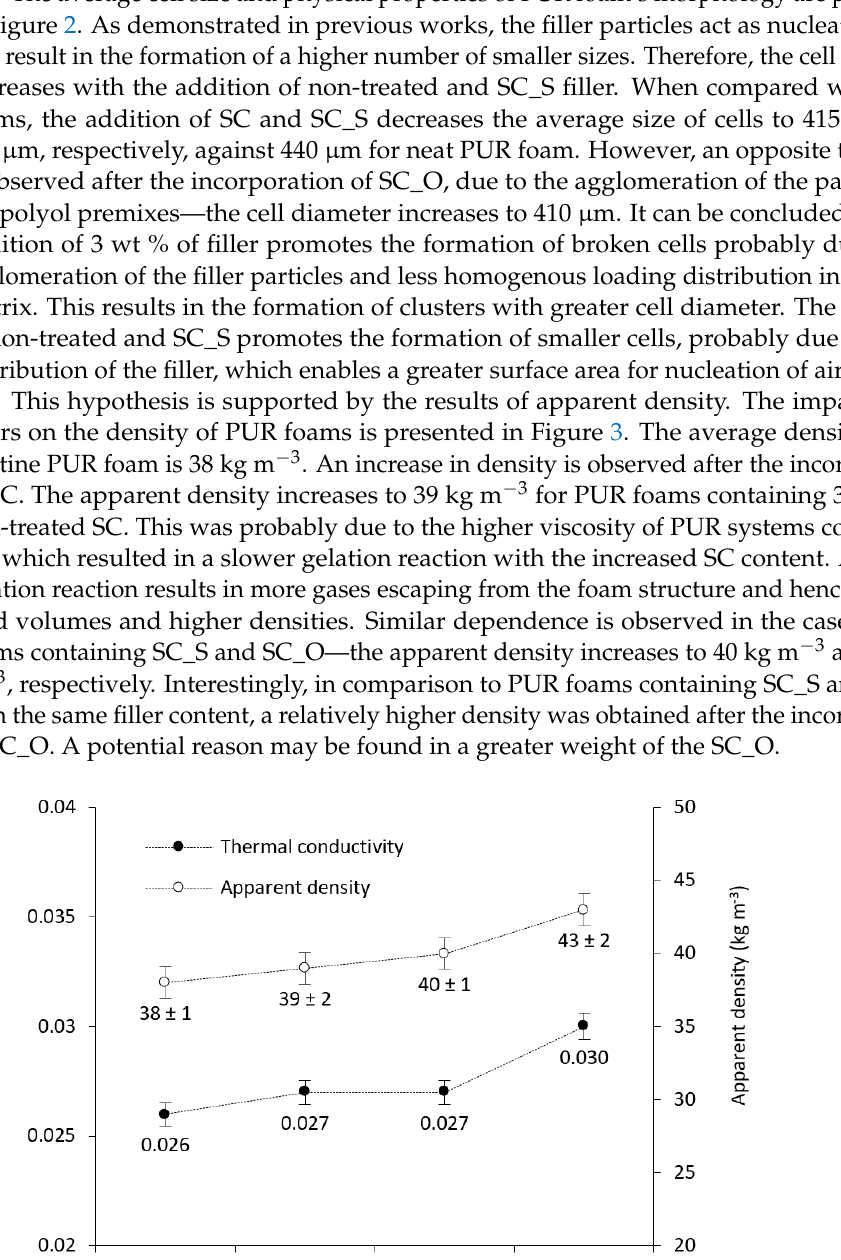
Figure 2. Cellular morphology and cell size distribution of ( a – c ) PUR; ( d – f ) PUR_SC; ( g – i ) PUR_SC_S; ( j – l ) PUR_SC_O.